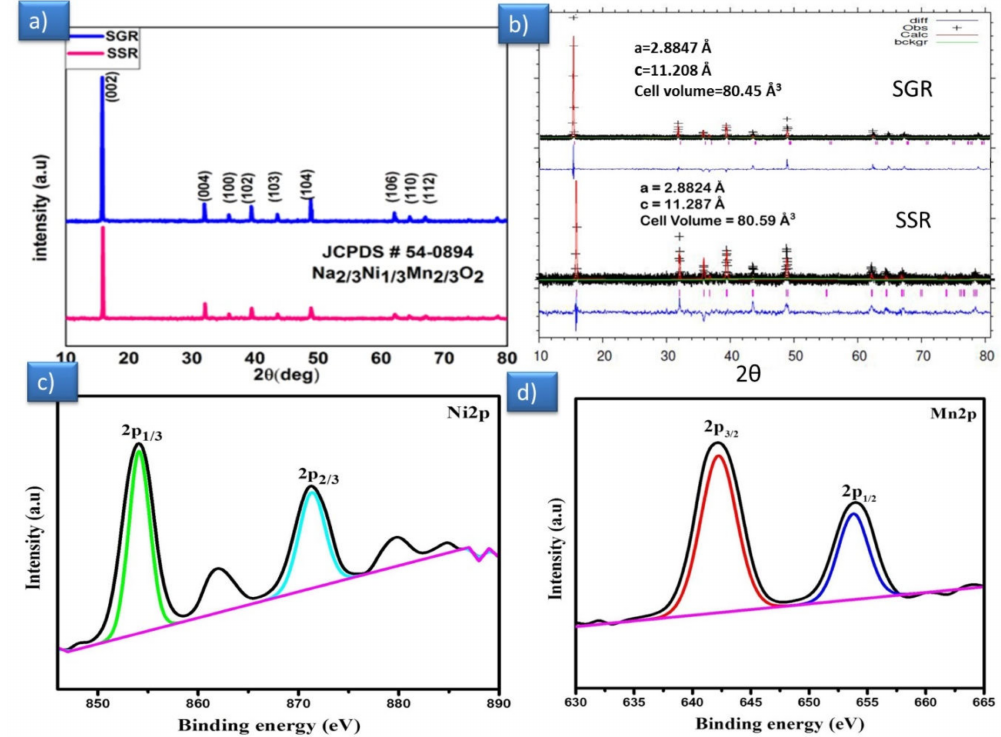
Figure 1. ( a ) X-ray di ff raction of samples P2-Na 2 / 3 Ni 1 / 3 Mn 2 / 3 O 2 (solid state reaction (SSR) and sol–gel reaction (SGR)), ( b ) refinement pattern with lattice parameters of P2-Na 2 / 3 Ni 1 / 3 Mn 2 / 3 O 2 SGR,